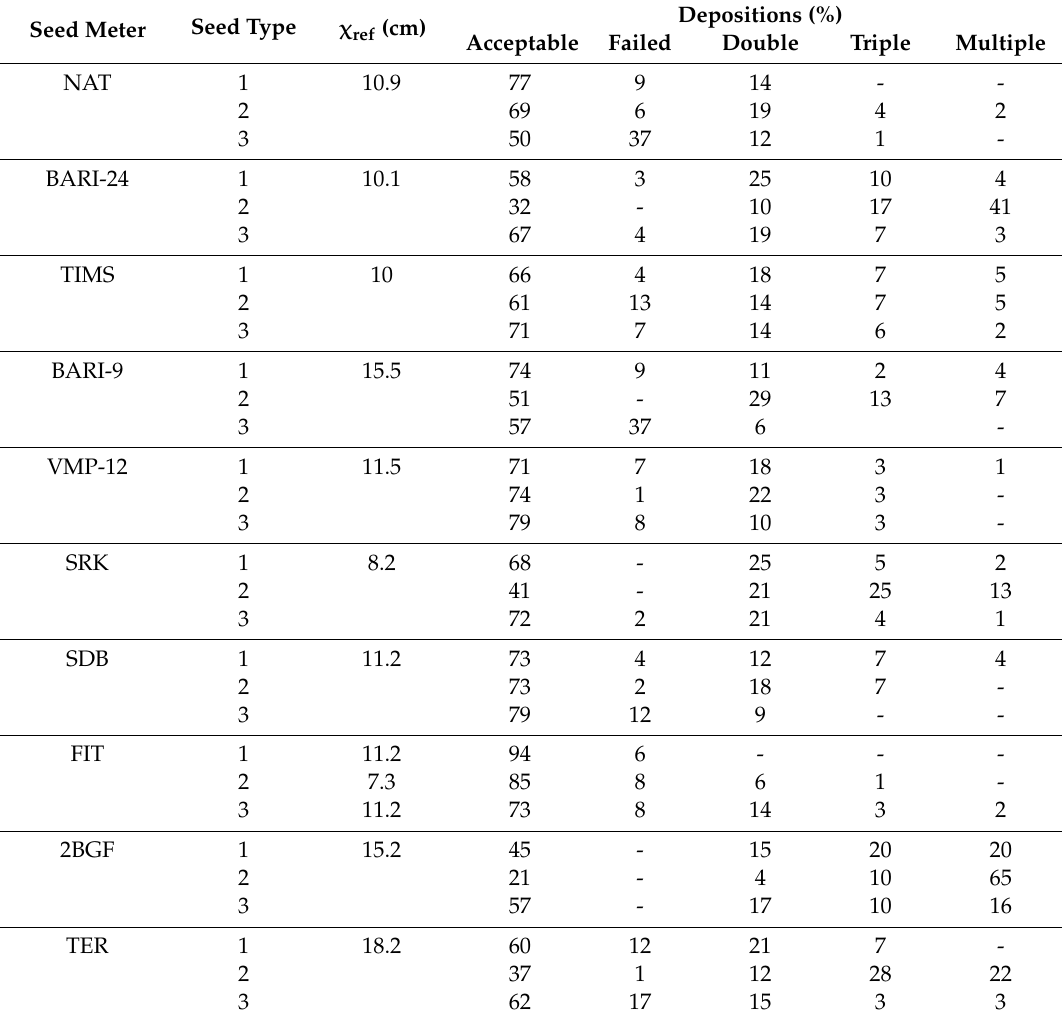
Table 3. Spatial deposition precision of seed meters for selected seed types. Seed